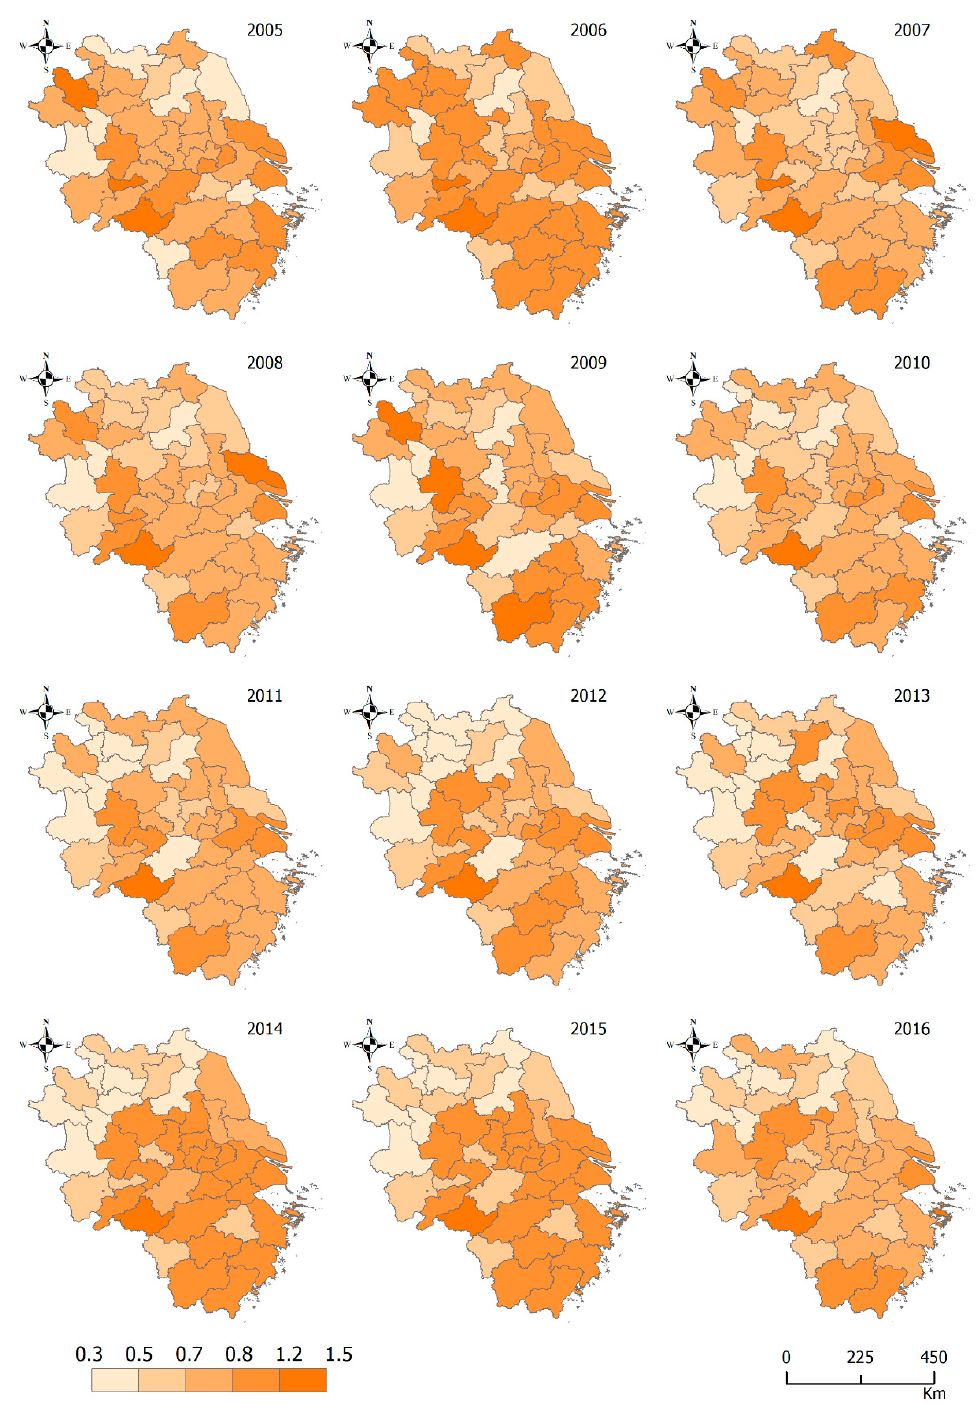
Figure 3. Spatiotemporal distribution of